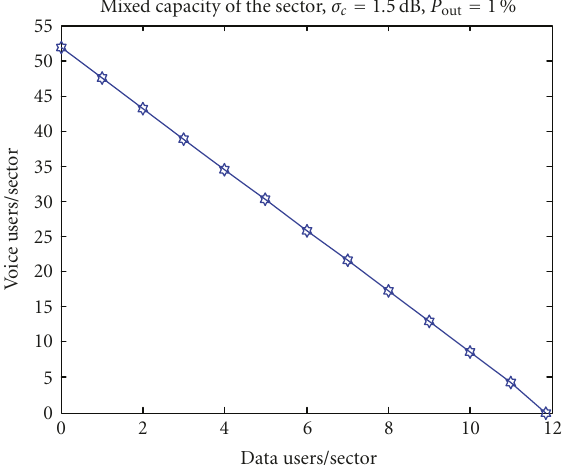
Figure 9: E ff ect of the antenna sidelobe level on the sector uplink